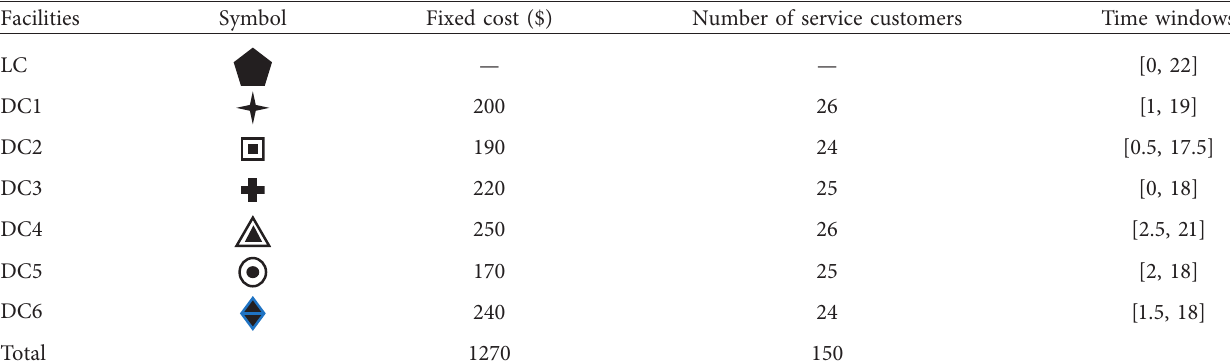
Figure 7: Location strategies obtained by clustering results. (a) Location strategy of {DC3, DC4, DC5}, (b) location strategy of {DC3, DC4, DC5, DC6}, and (c) location strategy of {DC2, DC3, DC4, DC5, DC6}. Table 3: Initial characteristics of logistics